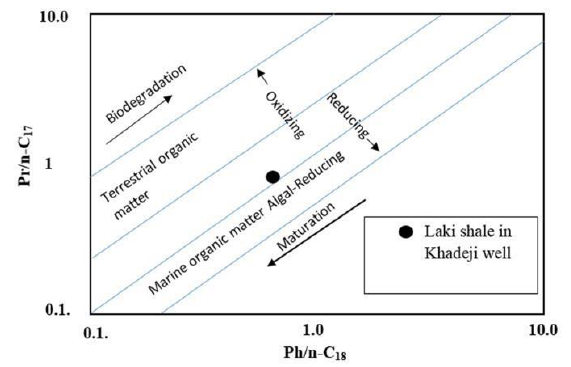
Figure 7: Showing Cross correlation of pristane/n-C 17 versus phytane/n- C 18 ratios of Laki Formation shales boundaries are after Connan and Cassou (Connan and Cassou, 1980).